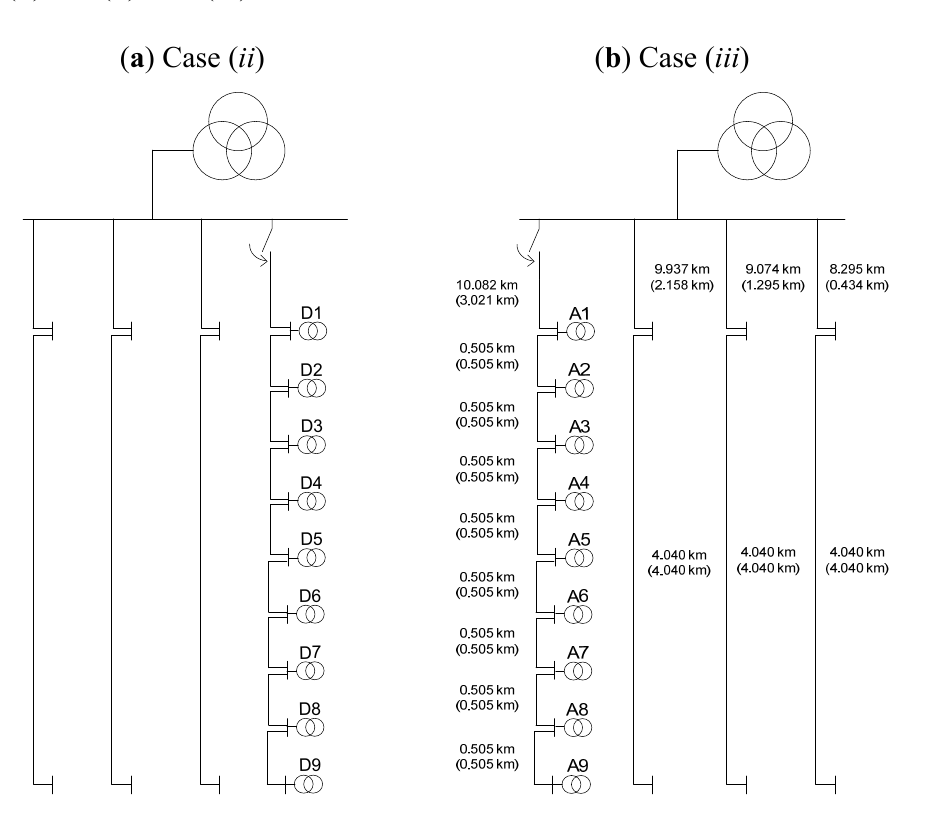
Figure 13. Schematic of the model representation of the internal network of NOWF